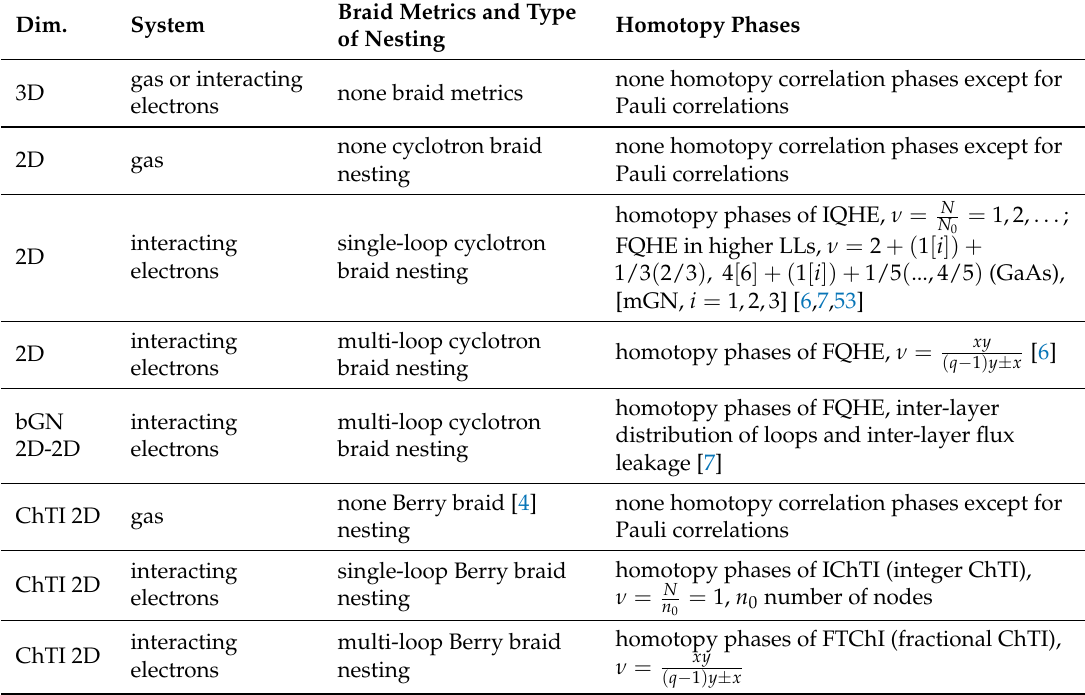
Table 1. Classification of multi-electron homotopy phases [m(b)GN—monolayer(bilayer)-graphene, ChTI—Chern topological